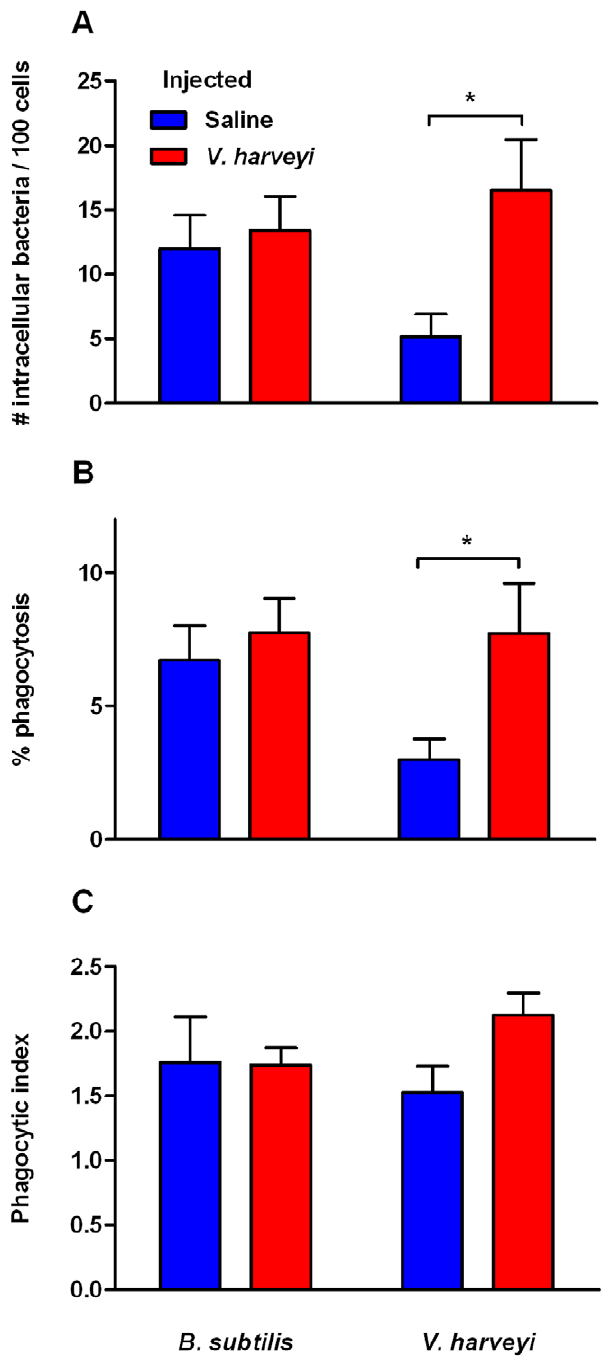
Figure 2. Elevation of phagocytic activity in juvenile shrimp blood cells following injection of inactivated bacteria. Juvenile Litopenaeus vannamei were injected with 100 m l of either formalin-killed Vibrio harveyi or sterile saline. After 7 d, monolayers of shrimp haemocytes were overlaid with a 50:50 mix of formalin-inactivated V. harveyi or an unrelated bacterium ( Bacillus subtilis ) and the number of phagocytosed bacteria of each type was recorded per cell. (A) Number of intracellular bacteria per 100 haemocytes, (B) percentage of haemocytes that showed phagocytic activity and (C) phagocytic indices (a measure of the number of bacteria internalised per phagocytic cell). * p , 0.05, 2-way ANOVA with Bonferroni post-test. Mean 6 1 S.E., N =8–9.